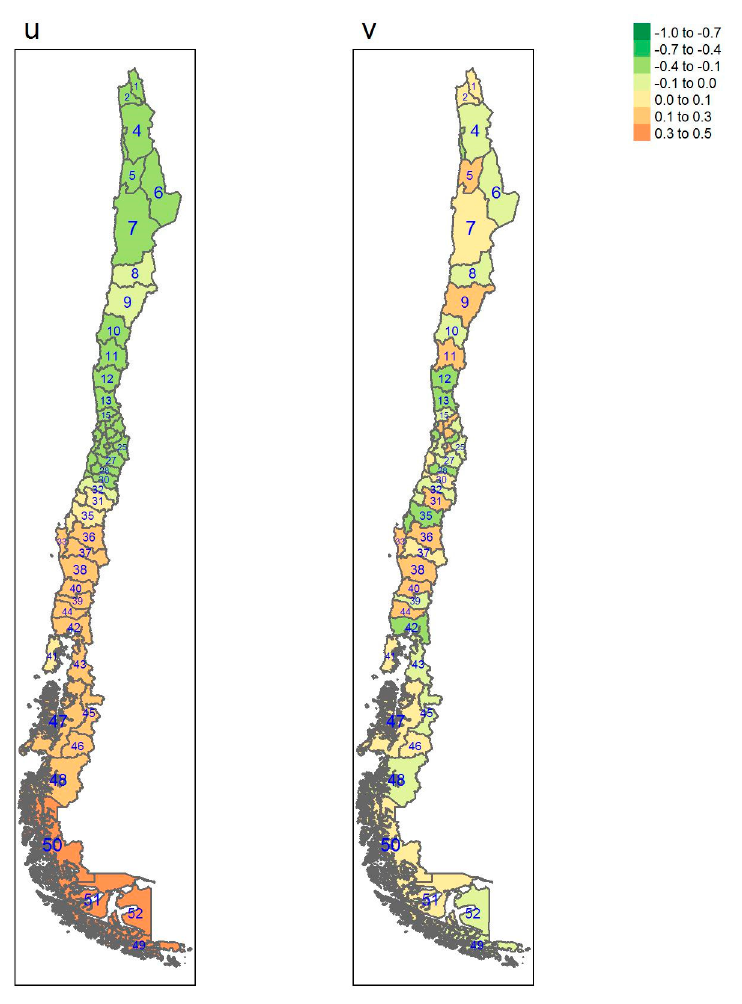
Figure 2. Multi-scale model heterogeneity effects for obesity (u: correlated effect; v: uncorrelated effect).